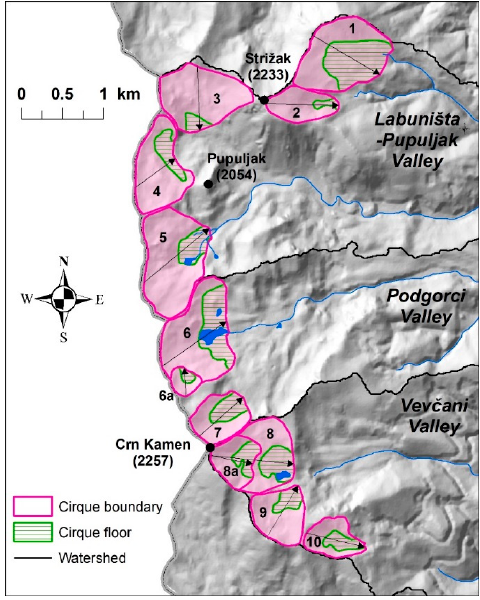
Figure 6. Cirques boundaries and cirque floors mapped in the studied area.